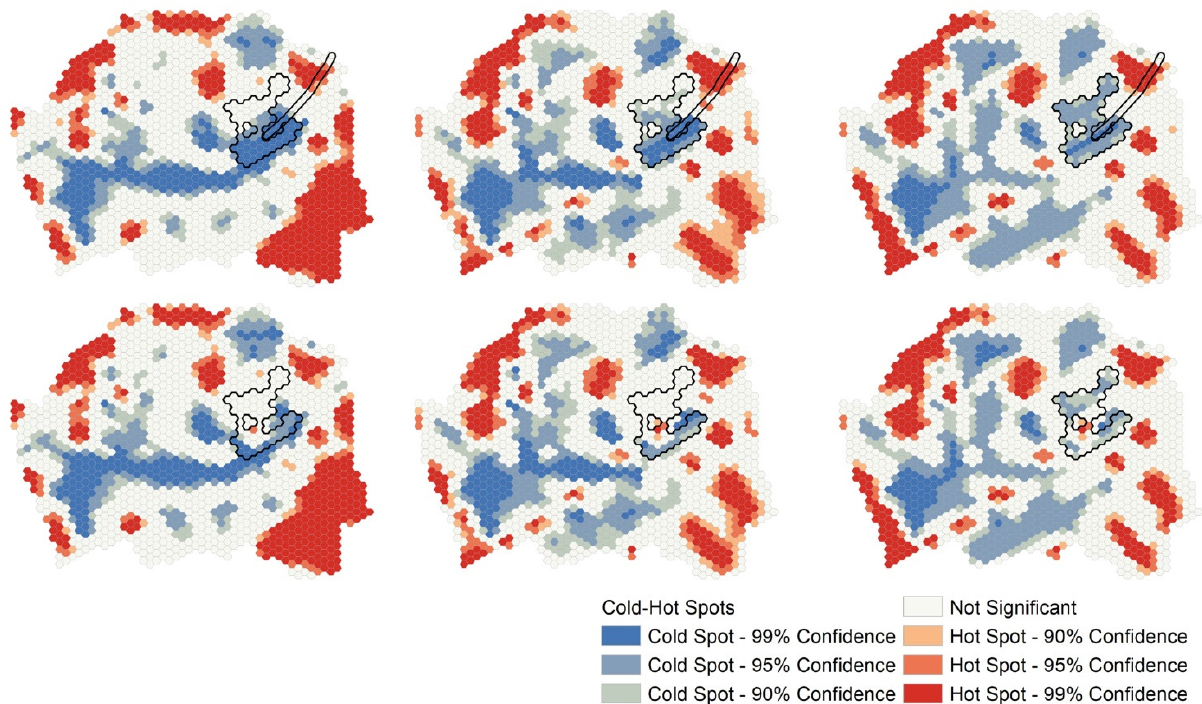
Figure 6. Compensation example for A4. Spatial distribution of ES. Upper row: total supply of provisioning ES (left), regulating ES (center), and cultural ES (right); center and lower rows: respective analyses of cold–hot spot for the current situation (center) and improvements after compensation (lower). The selected compensation area is indicated in black.